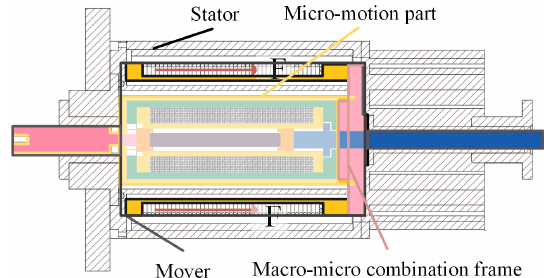
Figure 2. Structure diagram of macro-motion and micro-motion of the